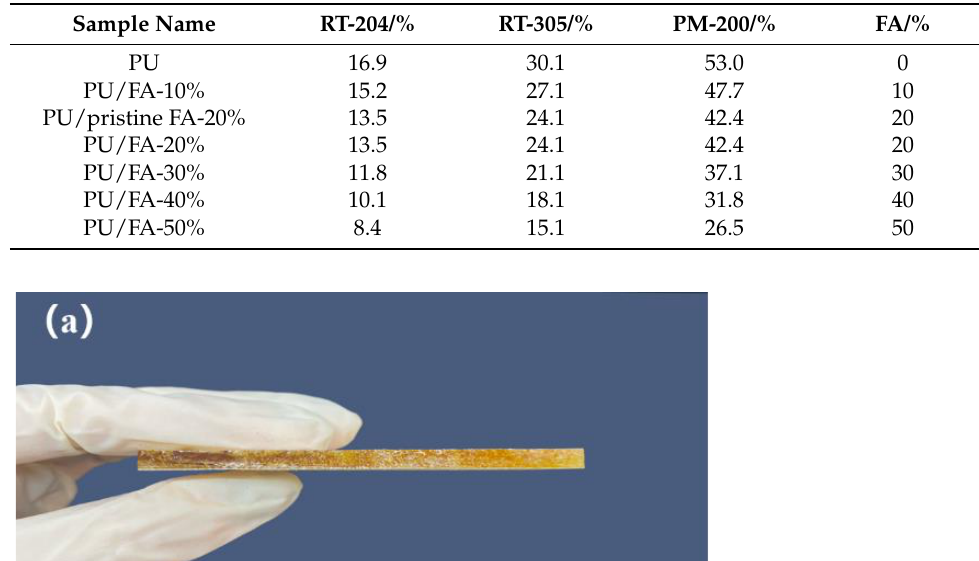
Table 1. Formulations of PU and PU/FA composites.